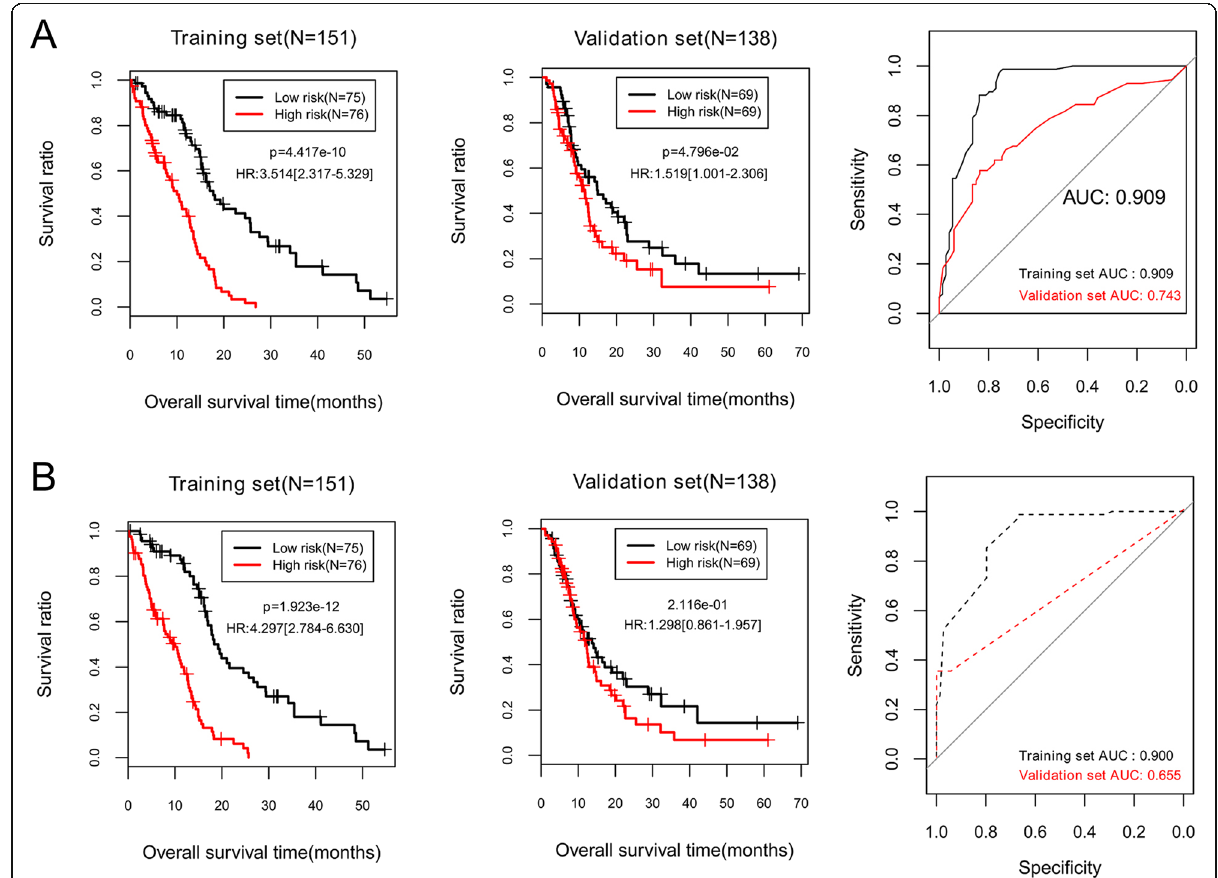
Fig. 2 Kaplan-Meier survival curves and the receiver operating characteristic curve (AUC) to evaluate predictive performance of the prognosis prediction models based on expression status of the selected biomarkers in the training set and the validation set. a , selected ten lncRNAs; b , selected eight mRNAs. All patients in each set are classified by each prognostic model into a high-risk group and